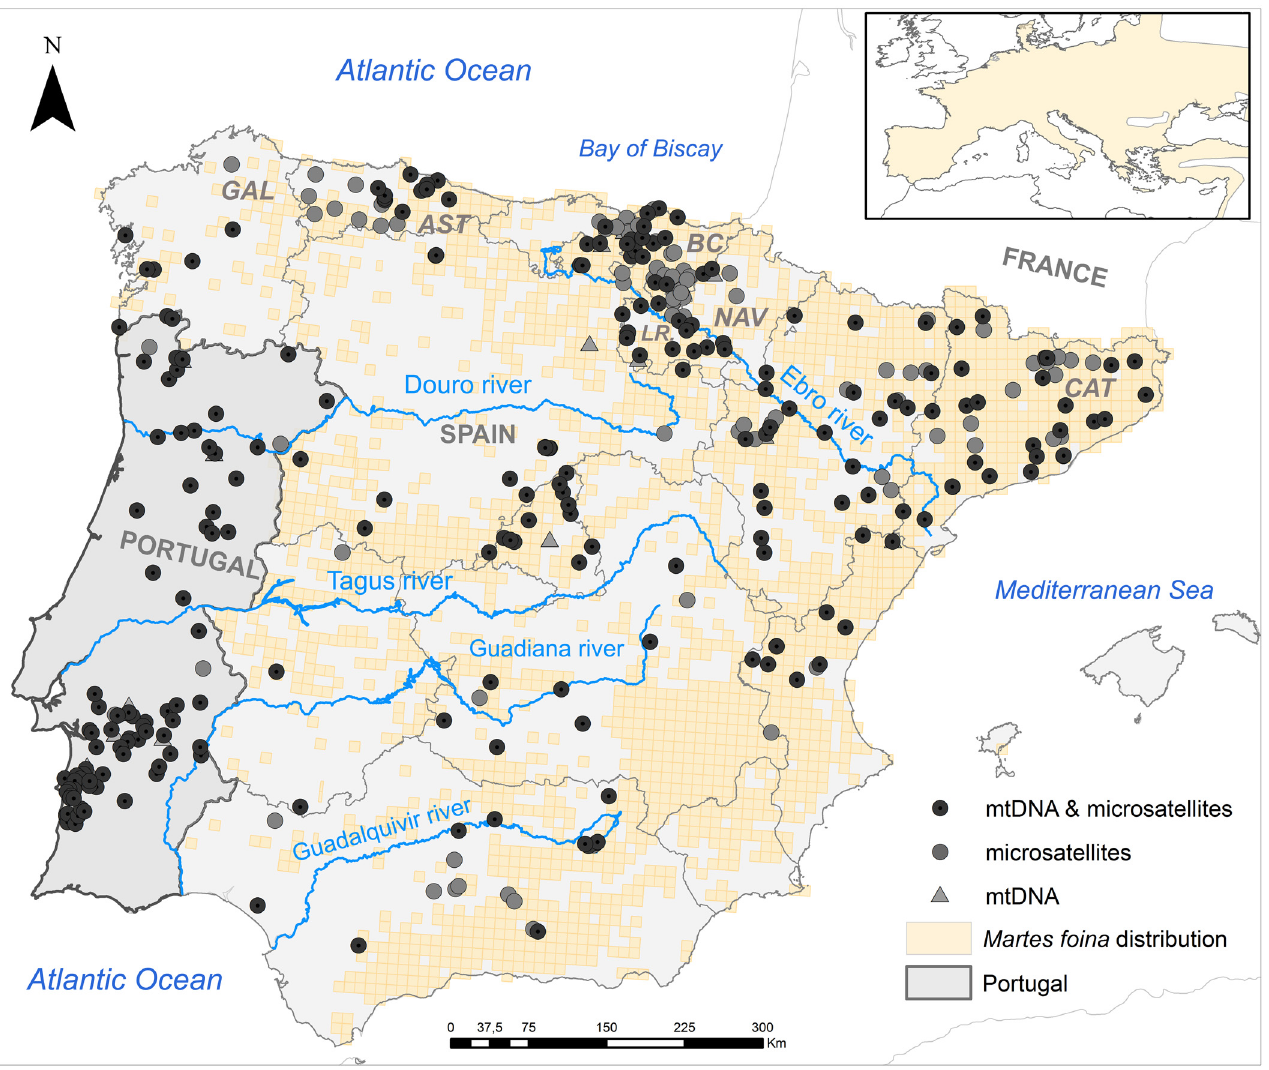
Fig 1. Map of the study area and of the stone marten distribution in Spain [41] with the geographic location of each genotyped (microsatellites) and/or sequenced (mtDNA) sample in the Iberian Peninsula. The inset shows the species range in Europe [26]. Dark grey dots, light grey dots and grey triangles represent individuals with microsatellite and mtDNA data, only microsatellite data and only mtDNA data, respectively. The Autonomous Communities mentioned in the paper are coded as follows: Galicia (GAL), Asturias (AST), Basque Country (BC), La Rioja (LR), Navarre (NAV) and Catalonia (CAT). The distributions maps were specifically generated based on the information provided in [41] and [26] using the country borders and the reference grids layers from the European Environmental Agency as background, available in http://www.eea.europa.eu/data-and-maps/ under a Creative Commons Attribution license, and are therefore for illustrative purposes